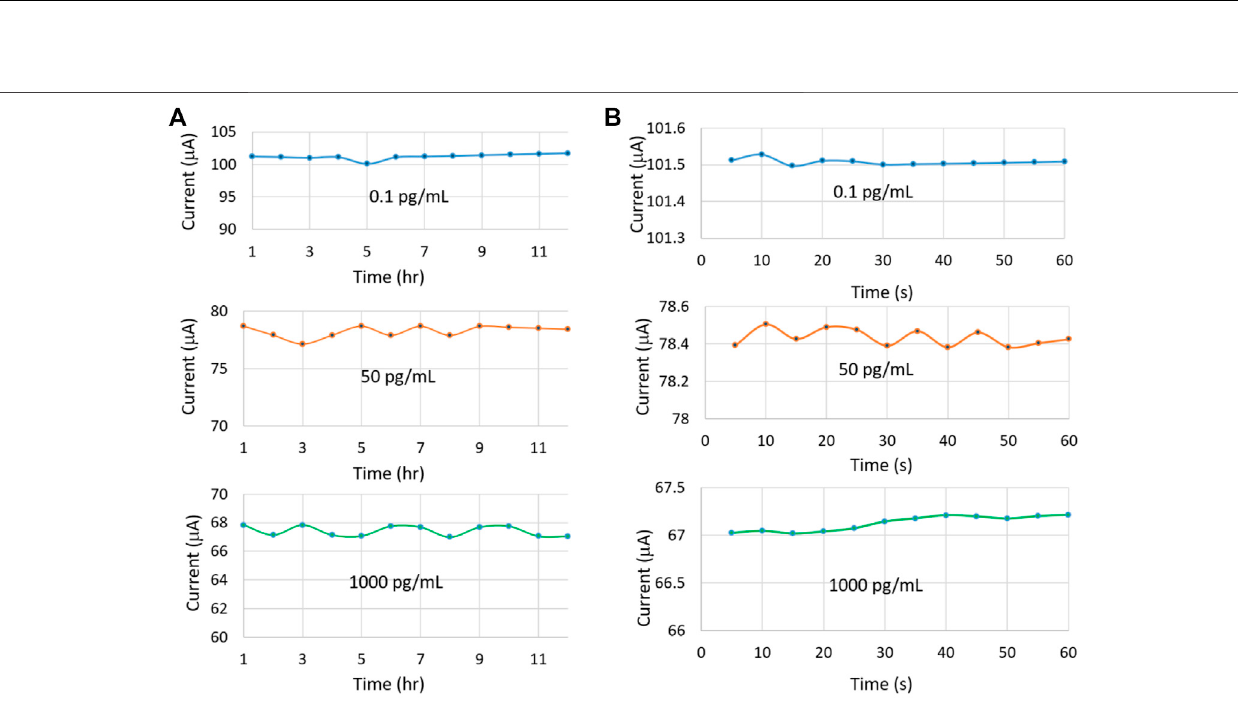
Frontiers in Nanotechnology |